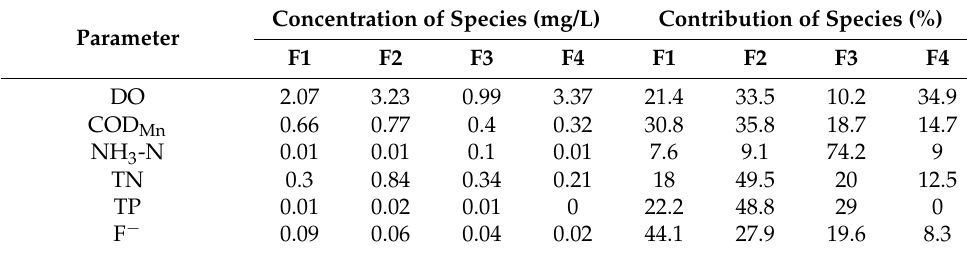
Table 7. Pollution source profile and contribution rate in the upstream.